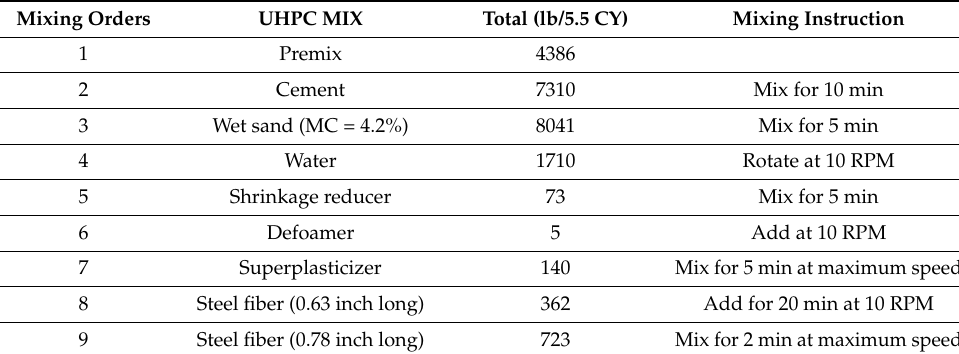
Table 3. Mixing proportions and mixing instructions for